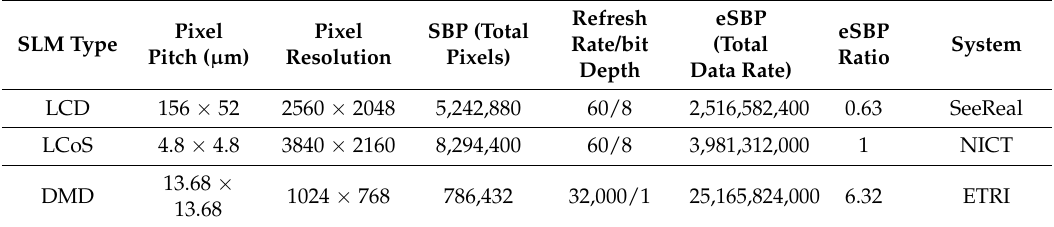
Table 3. Comparison of SBP and eSBP for different SLM devices.